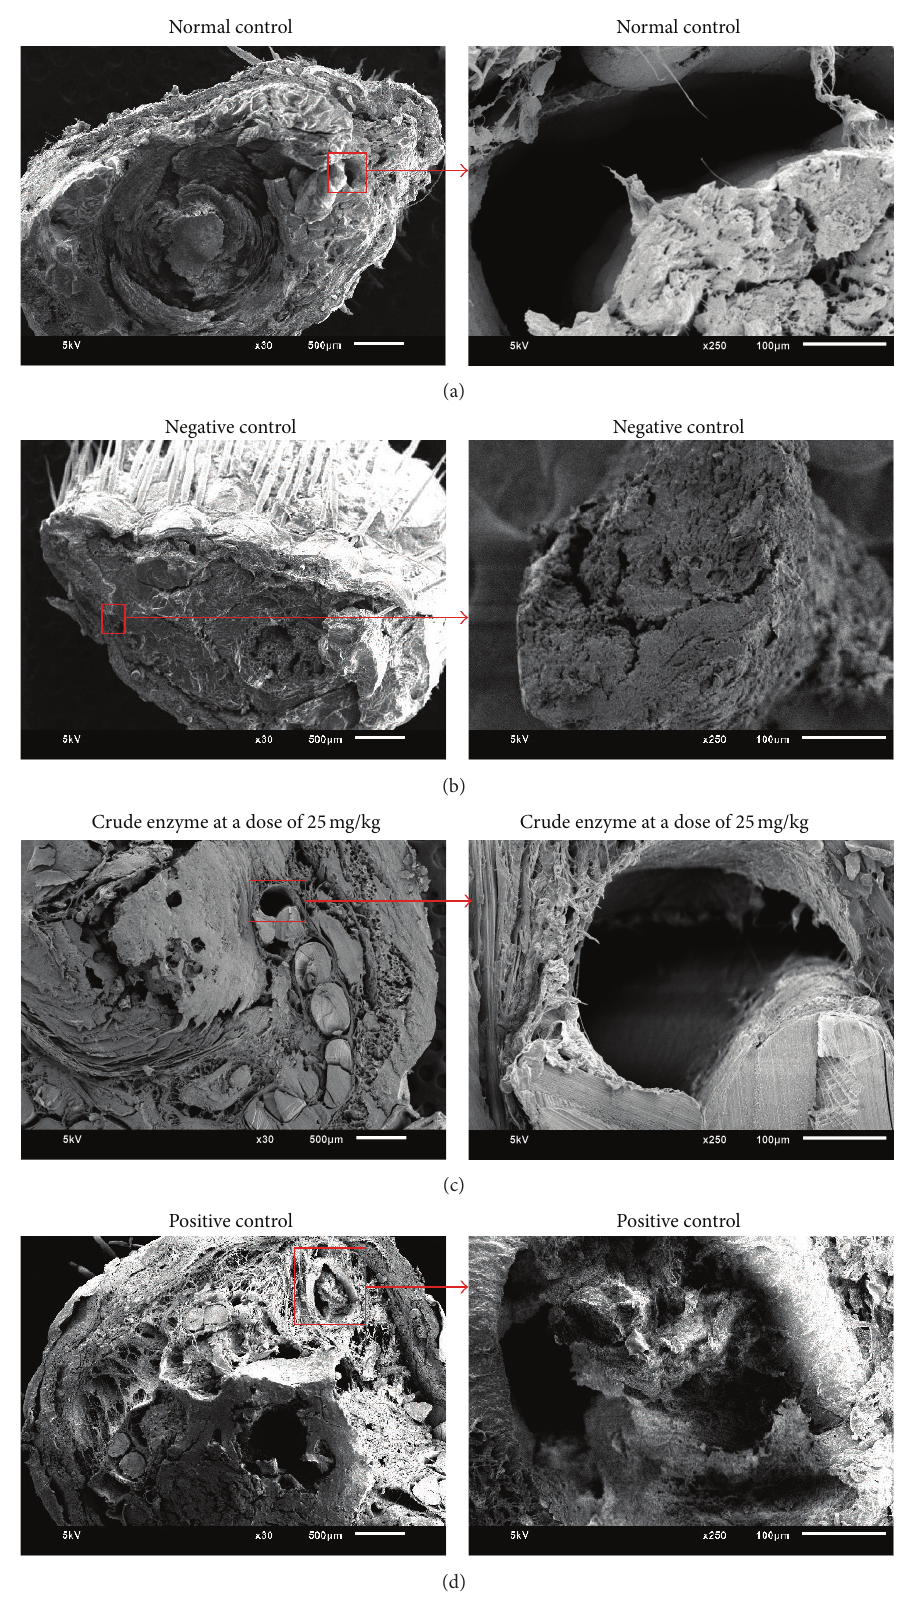
Figure 4: Scanning electron microscopy of the tail cross section from the experimental rats (including blood vessels). Normal control (a); negative control (kappa carrageenan injection) (b); crude enzyme of Stenotrophomonas sp. 25 mg/kg BW (c); positive control (lumbrokinase 25 mg/kg BW)